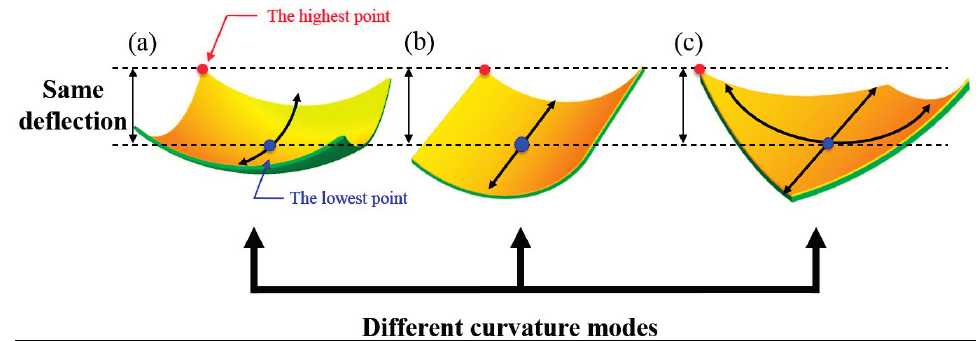
Figure 1. Typical warpage modes of square shape specimens: ( a ) spherical shape; ( b ) cylindrical shape; and ( c ) cylindrical diagonal